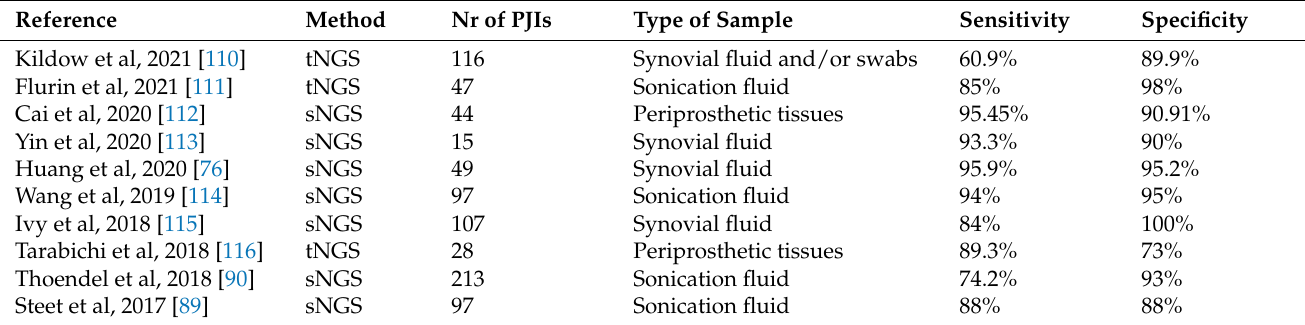
Table 4. Comparison of studies on the use of NGS for the diagnosis of